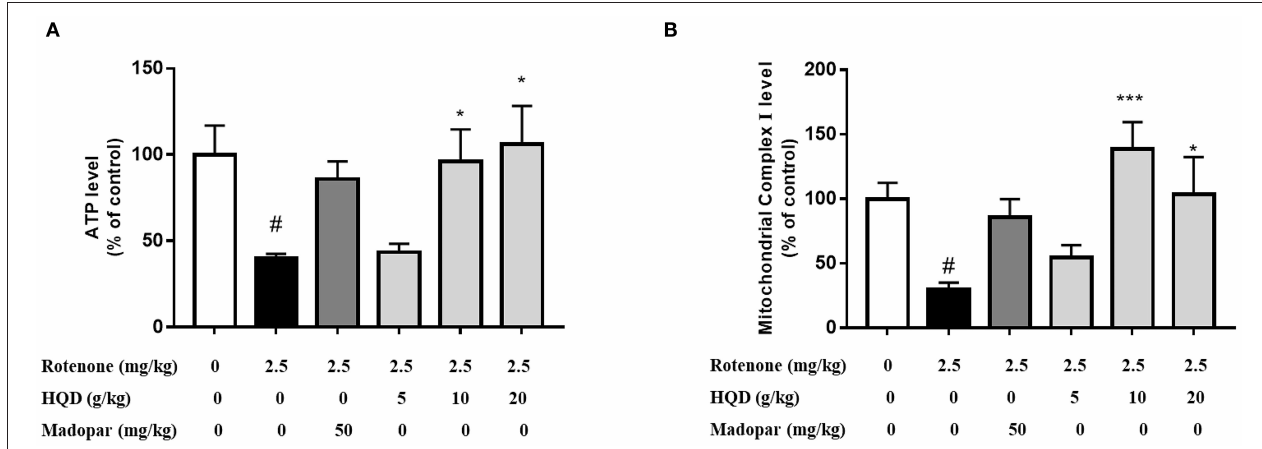
FIGURE 6 | Effect of HQD on mitochondrial function of rotenone-induced PD rats. (A) The content of ATP in cerebral cortex. (B) The activity of mitochondrial complex I in cerebral cortex. # P < 0.05 vs. control group; * P < 0.05, *** P < 0.001 vs. rotenone group ( n =